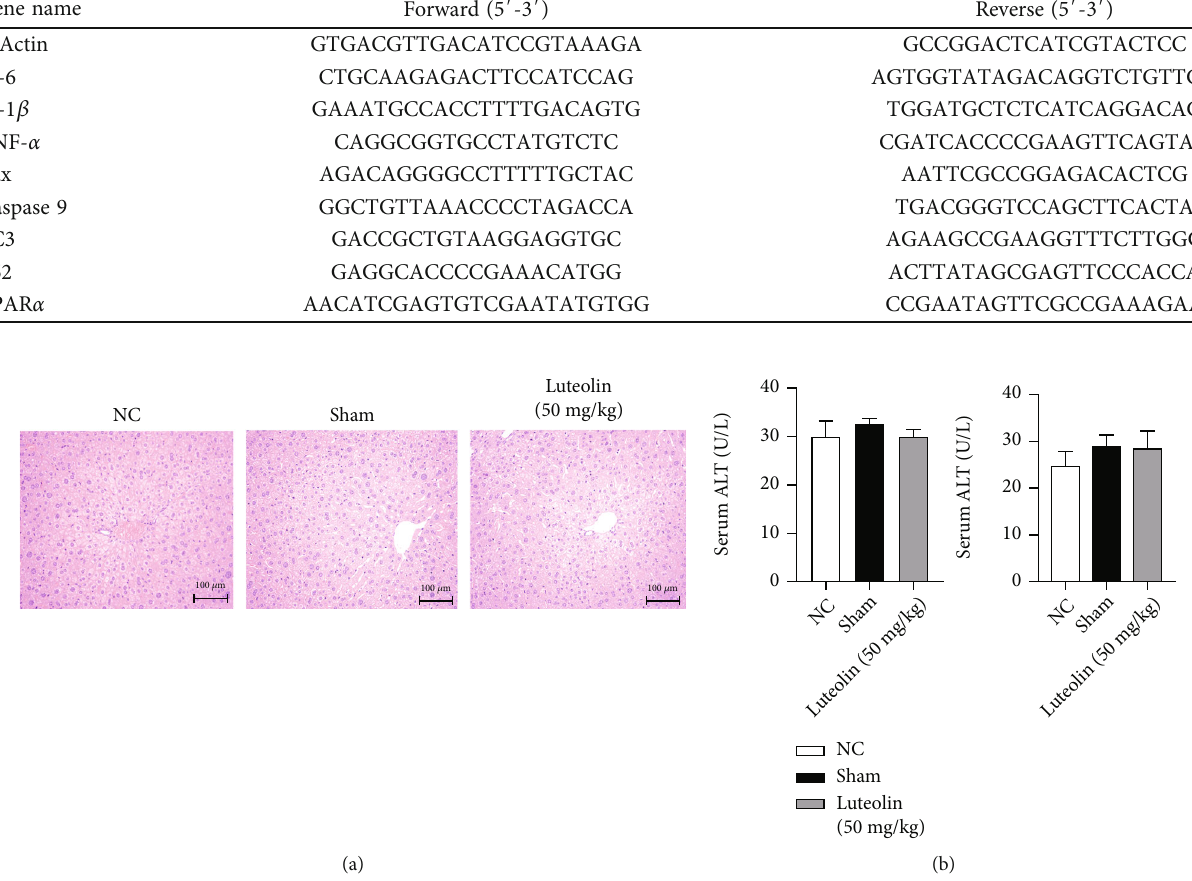
Figure 1: E ff ects of luteolin (50 mg/kg) and laparotomy on normal liver tissues. (a) Representative H&E staining in sections of the liver (original magni fi cation, × 200). (b) Serum ALT and AST levels are presented as mean ± SD ( n = 6 , p > 0 : 05